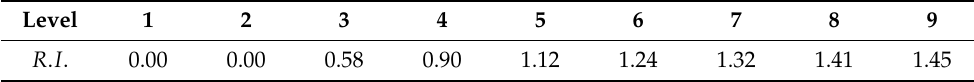
Table 2. Random index value for each level of